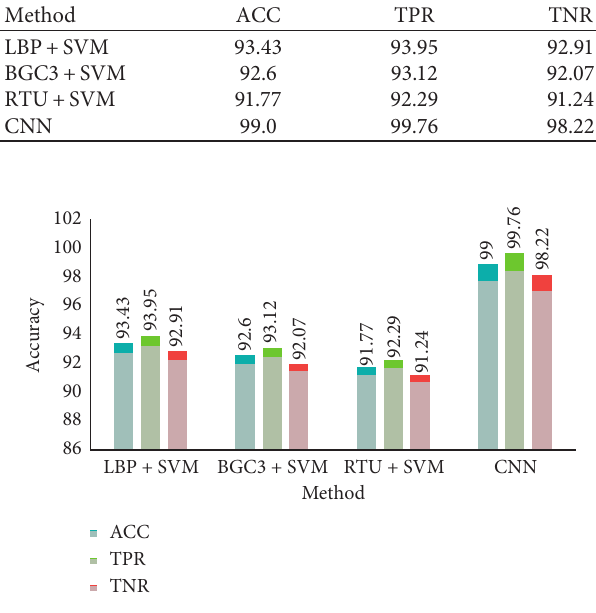
Figure 2: Static texture recognition results.